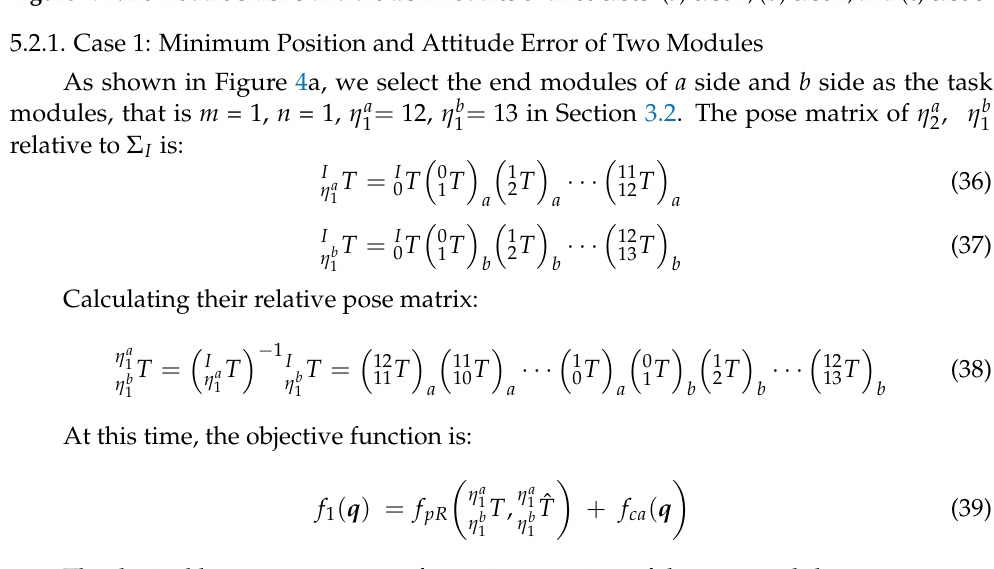
Figure 4. Nine module SMSRS and the task modules of three cases: ( a ) case 1, ( b ) case 2, and ( c ) case